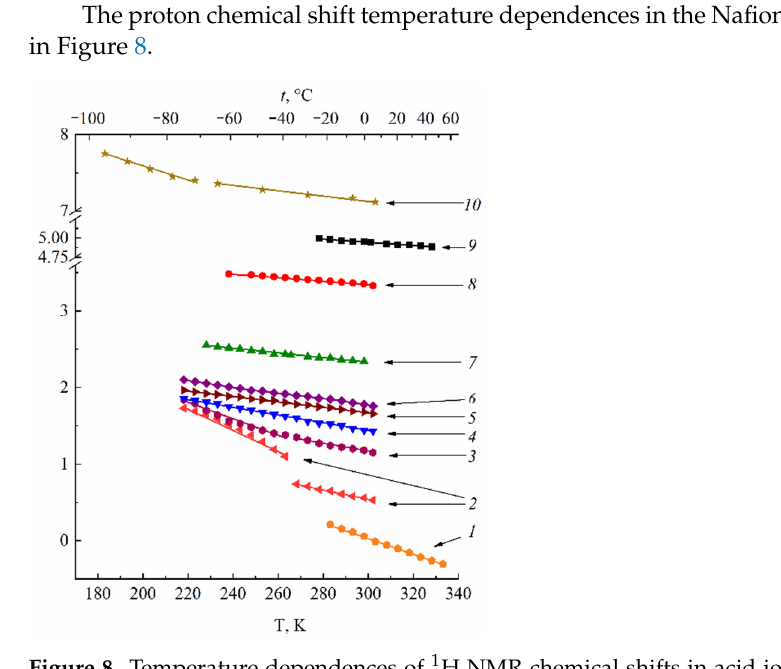
Figure 8. Temperature dependences of 1 H NMR chemical shifts in acid ionic form of the Nafion membrane at different water contents ( δ H2O is the bulk water chemical shift equal to 4.30 ppm relative to TMS, at 20 ◦ C). (1) Bulk H 2 O; (2) RH = 98% ( λ = 17.5 ± 0.4); (3) RH = 95% ( λ = 12 ± 0.4); (4) RH = 78% ( λ = 7.4 ± 0.4); (5) RH = 64% ( λ = 6.4 ± 0.4); (6) RH = 58% ( λ = 5.8 ± 0.4); (7) RH = 32% ( λ = 4.4 ± 0.4); (8) RH = 10% ( λ = 3.2 ± 0.4); (9) RH = 0% ( λ = 1.9 ± 0.4, drying on P 2 O 5 or at 110 °С); (10) is the chemical shift temperature dependence in acid ionic form of the Nafion NRE-212 membrane. Adapted from [41,75].